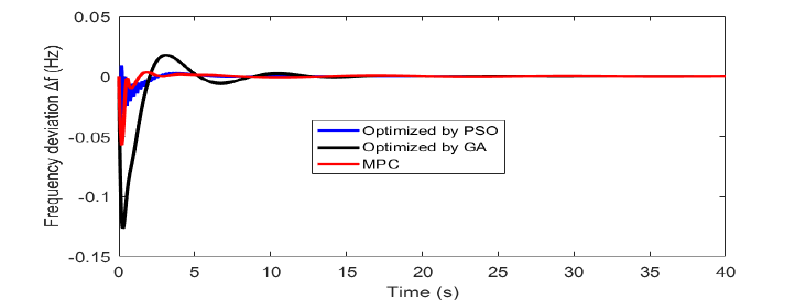
Figure 13. Frequency deviation in Area 1 for the third case.